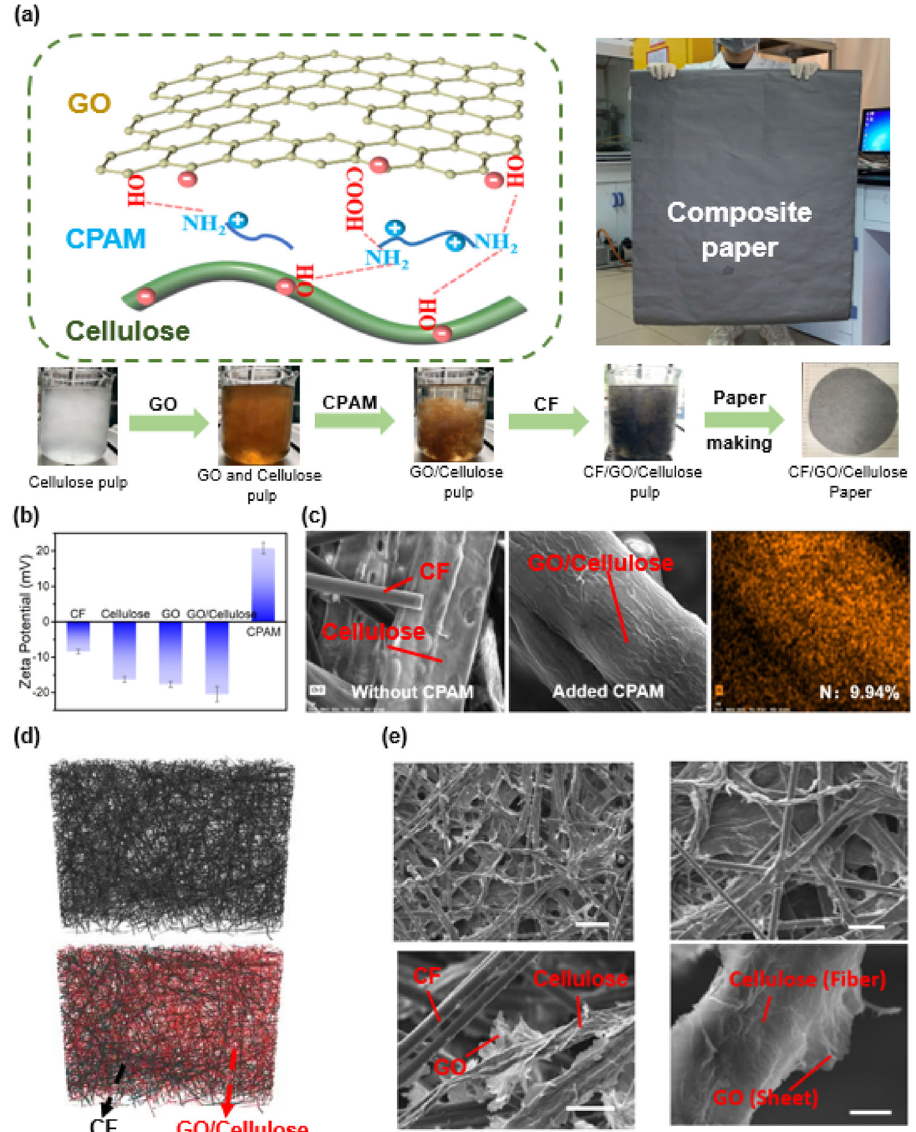
Fig. 2 Preparation and characterization of CF/GO/cellulose paper. a Fabrication of CF/GO/cellulose paper. Cationic polyacrylamide (CPAM) was used to control the interfacial interactions to enable the assembly of GO sheets onto the surface of the cellulose fi bers. b Electrostatic interaction. Zeta-potential measurements indicate the electrostatic charge of the components. c The distribution of CPAM was detected by EDS. EDS shows that CPAM (determined by nitrogen) is localization on the surface of cellulose. d 3D structure by micro-CT. Micro-CT shows a homogeneous distribution of the CF and cellulose fi bers in the CF/GO/cellulose composite. e Surface morphology by SEM. Scanning electron microscopy images show the composite ’ s homogeneous distribution and also the assembly of the GO sheets on the cellulose surface. Scale bar is: top left 50 μ m, bottom left 10 μ m, top right 10 μ m, and bottom right 1 μ